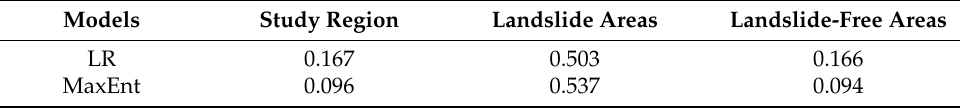
Table 4. The landslide occurrence probability within different regions.